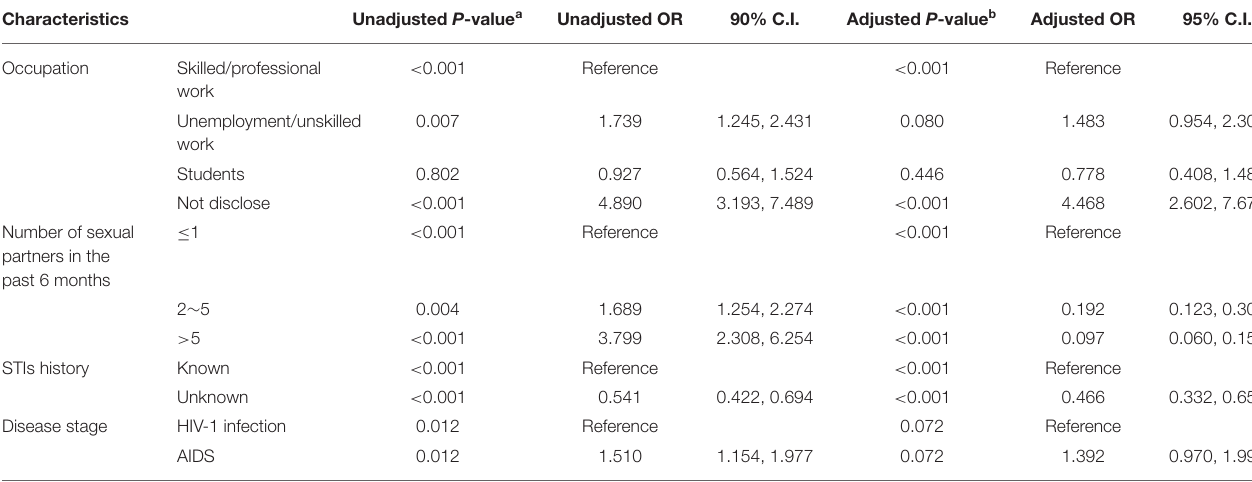
TABLE 4 | Factors associated with no syphilis testing among HIV-infected MSM from 2008 to 2012 in Guangzhou, China.